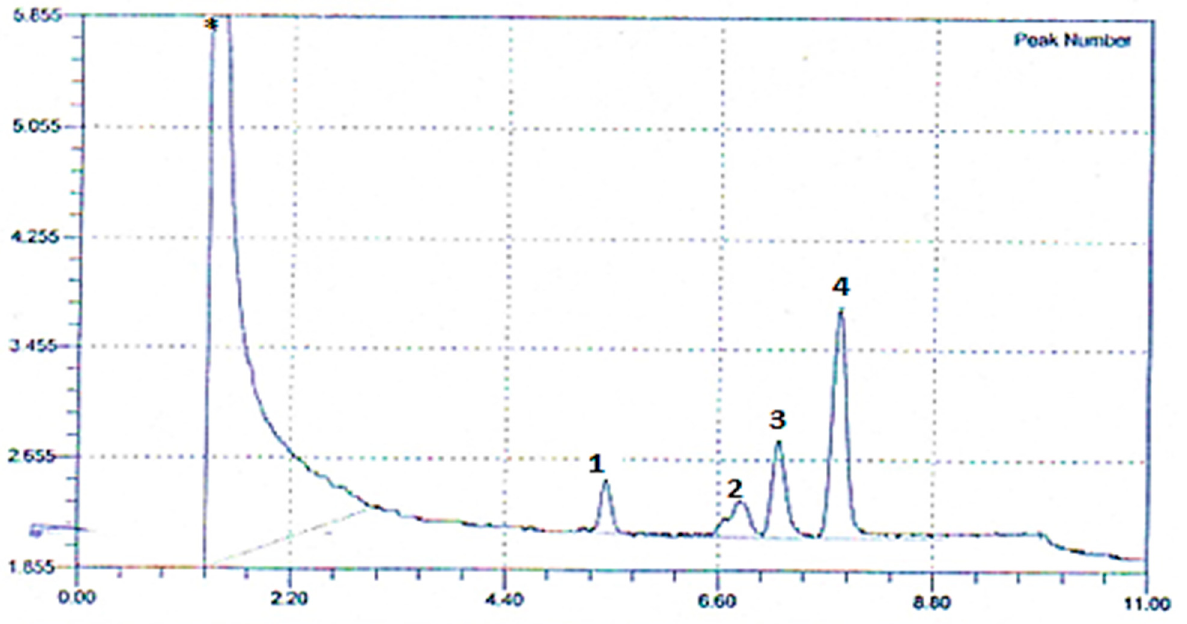
Figure 16. Barthenosteriode at 10 mL/L GLC. (* is the solvent, 1 is the palmitic acid, 2 is oleic acid, 3 is a Linoleic acid and 4 is the α - α linolenic acid) of chia ( Salvia hispanica L.) fixed oil content as impacted by various bio-stimulating materials.